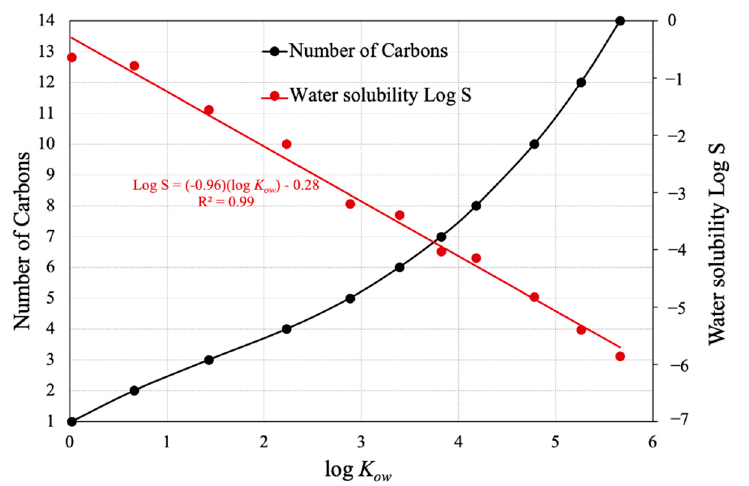
Figure 1. The log K ow of the piperonyl amide fluorescent tracers with corresponding number of carbon atoms and water solubility, log S.